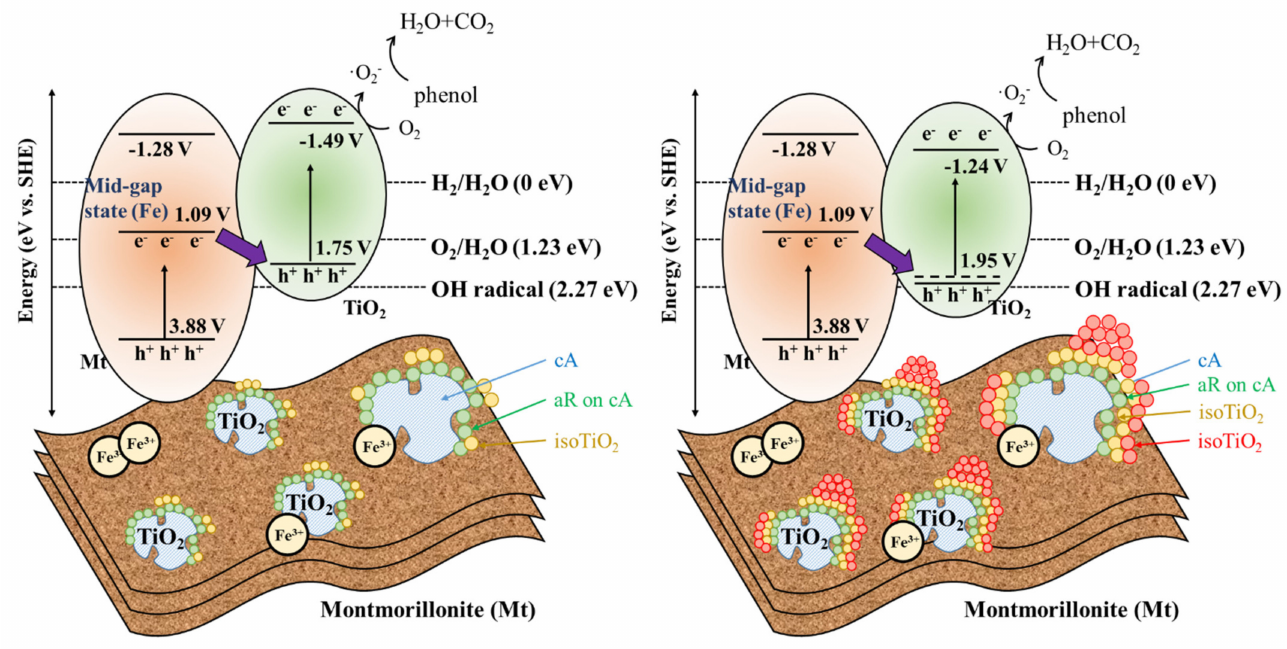
Figure 12. Effects of radical scavengers (ethanol, isopropanol, and para-benzoquinone) on the photocatalytic degradation of phenol in the Fe/Mt/TiO 2 composite synthesized at 70 ◦ C. Isopropanol is the · OH − scavenger, ethanol is the h + scavenger, and para-benzoquinone is the O 2 −